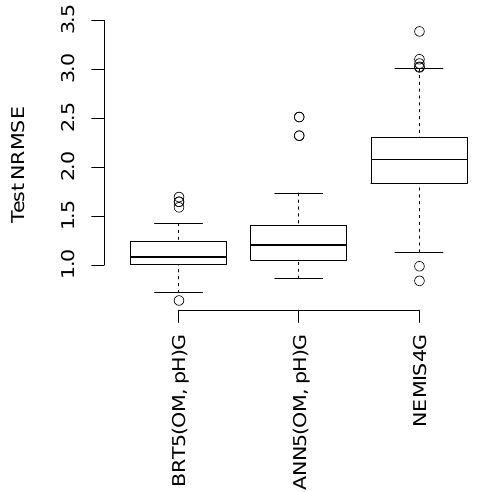
Fig. 6. Boxplot (description of quartiles with maximum at 1.5 interquartile range) of prediction performance (independent validation) of ANN5(OM, pH)G, BRT5(OM, pH)G and NEMIS4G (without Henault and Germon (2000) and Ryden (1983) records). Circles are outlier